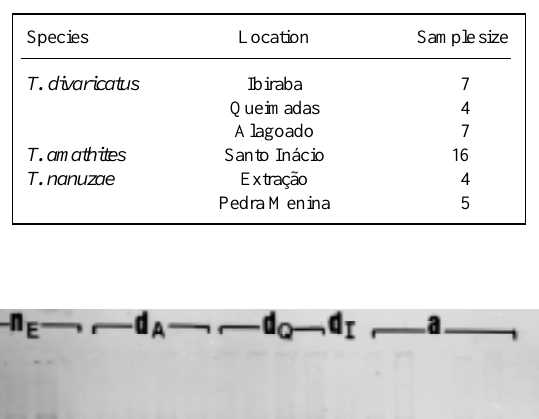
Table I - Sample sizes of the populations from the three species of the Tropidurus nanuzae